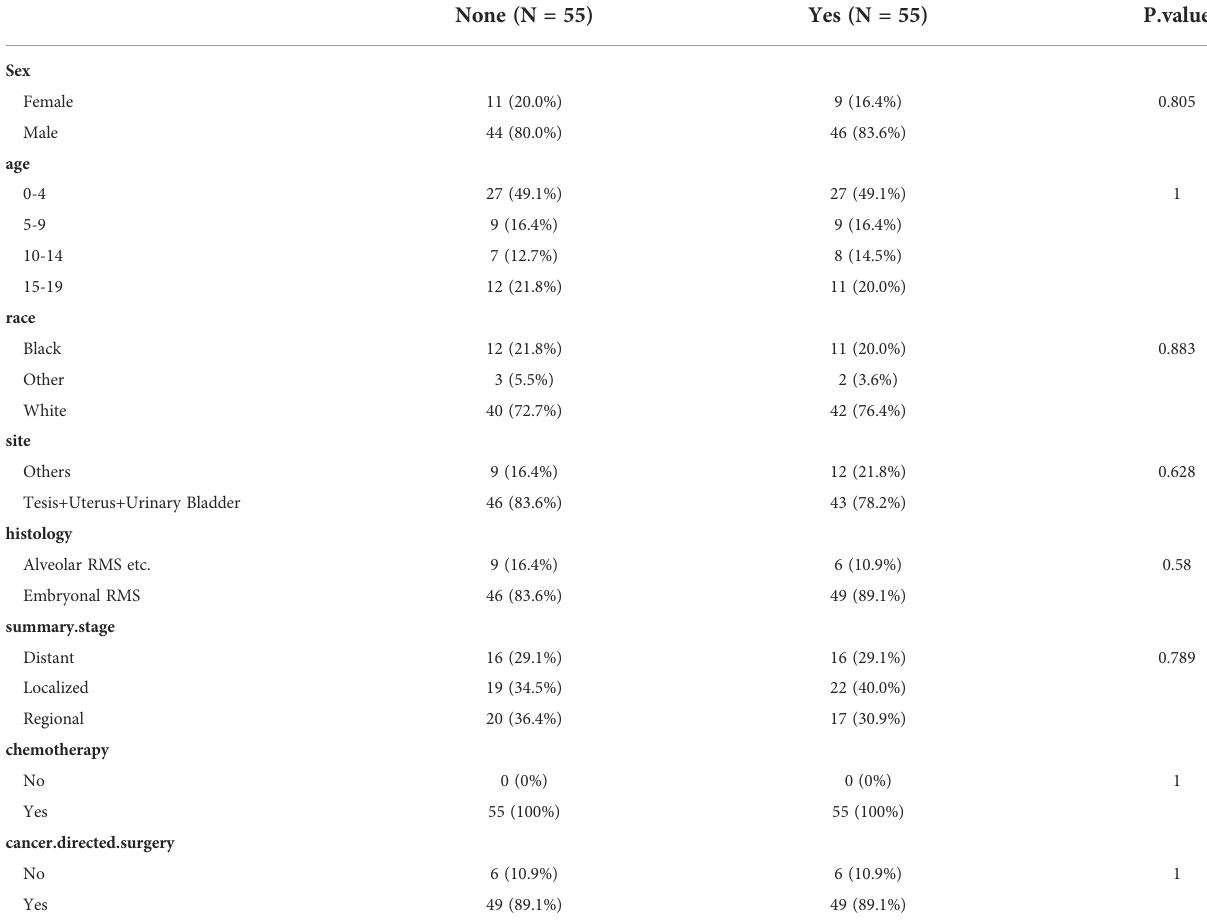
TABLE 3 Characteristics of patients after propensity score matching.